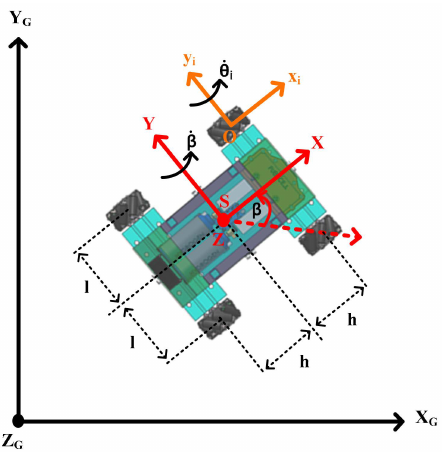
Figure 2. Two-dimensional coordinate system representation of